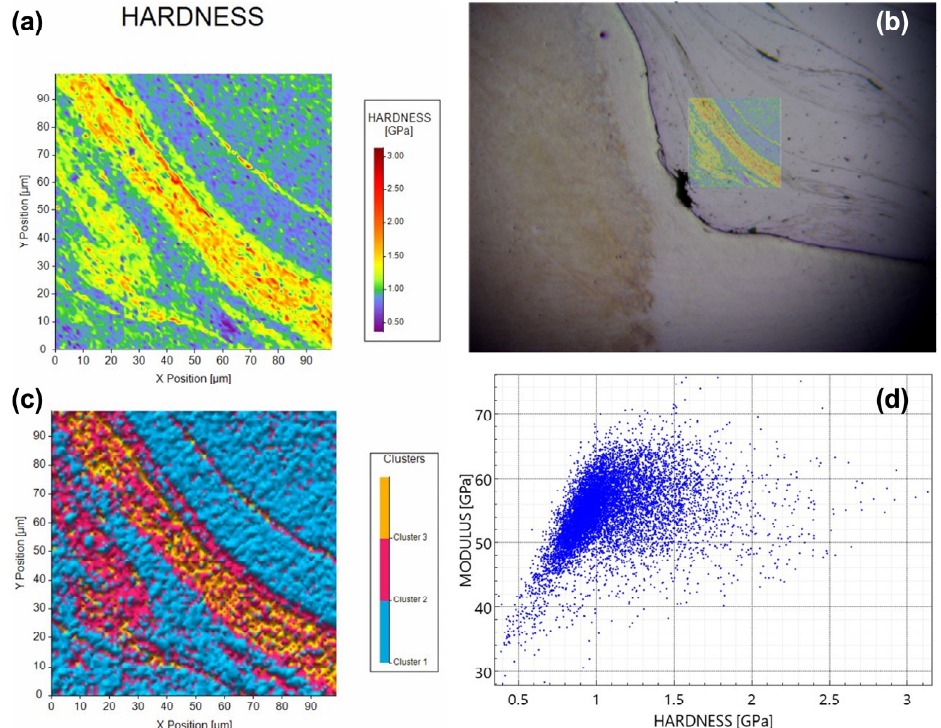
Figure 9. ( a ) Nanomechanical property map or contour plot wherein the range of values obtained are